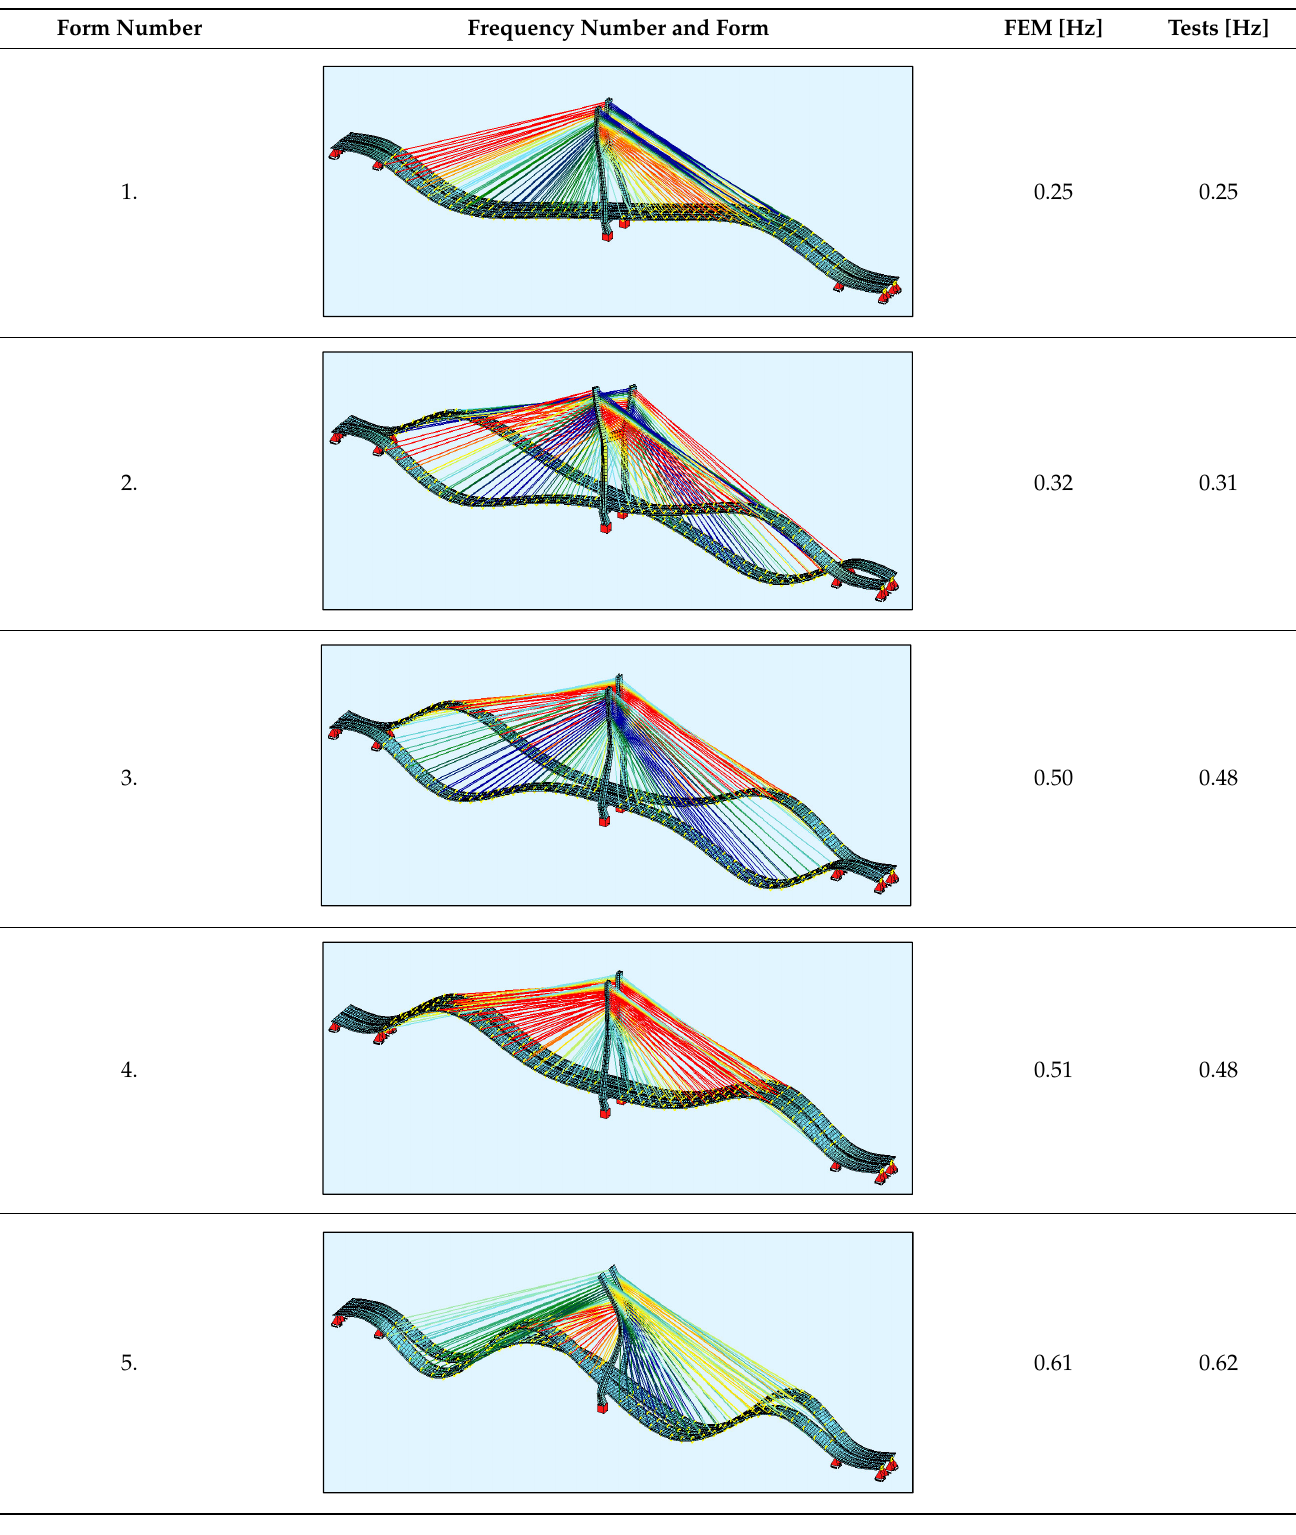
Table 4. Comparison of the calculated and measured frequencies.